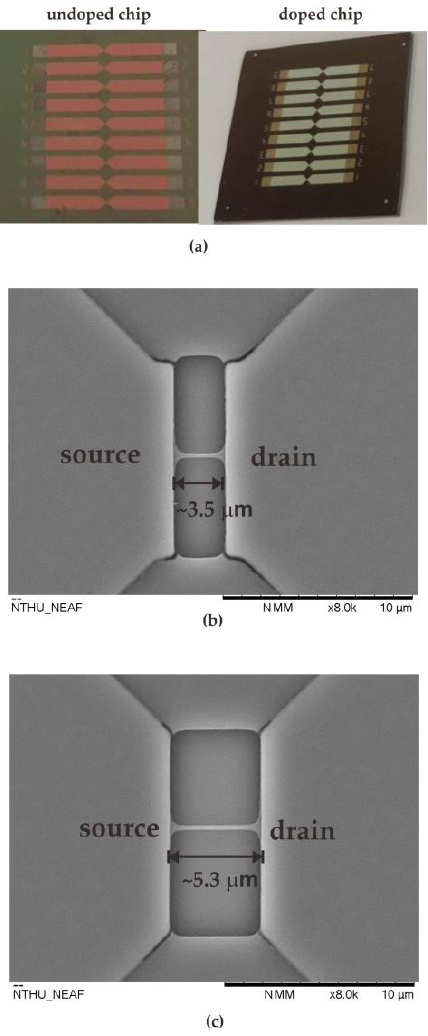
Figure 2. Photographs and top-view SEM images of NWGS. ( a ) photographs of the NWGS; ( b ) top- view SEM image of doped/undoped nanowire sensor with length of 3.5 μ m; ( c ) top-view SEM image of doped/undoped nanowire sensor with length of 5.3 μ m.